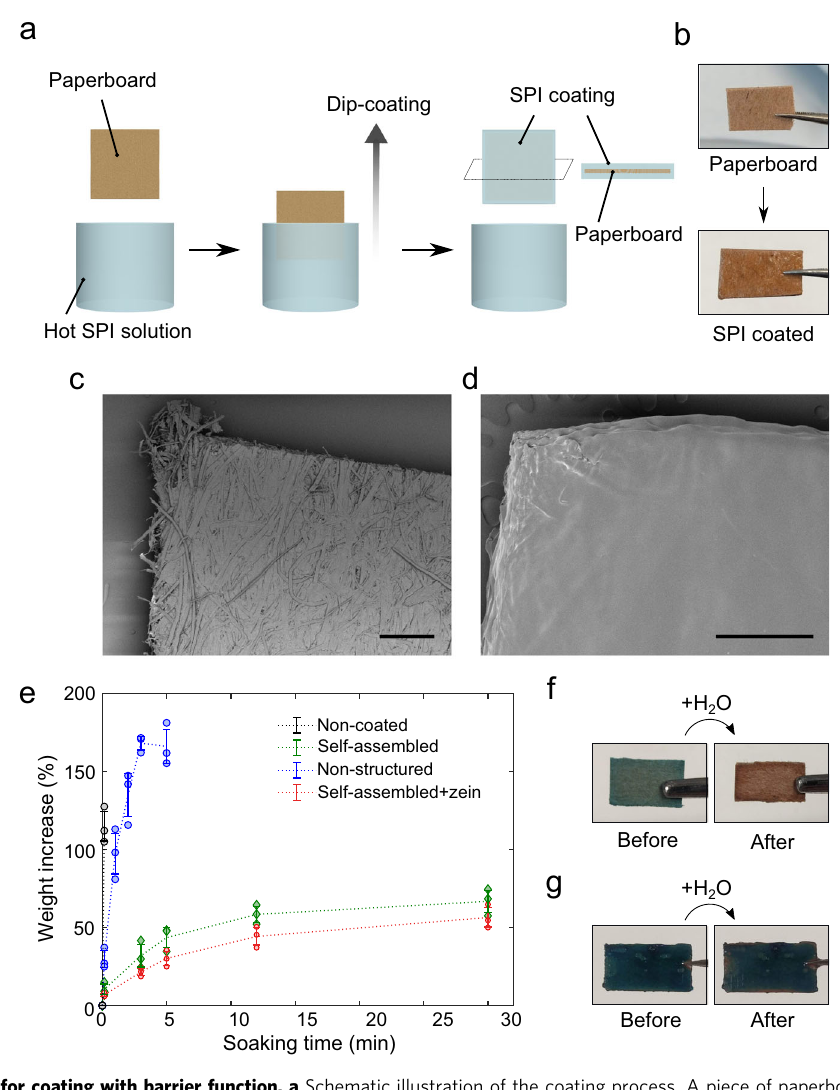
Fig. 6 Plant protein fi lm for coating with barrier function. a Schematic illustration of the coating process. A piece of paperboard was dipped in the SPI solution and pulled out slowly, leading to the formation of a gel coating its surface. The paperboard was allowed to dry at room temperature to achieve an anhydrous thin layer of coating. b Optical images of paperboards before and after SPI coating. c , d SEM images of paperboard without ( c ) and with ( d ) SPI coating. Scale bars represent 500 μ m. e Water uptake of the treated and untreated paperboards measured over 30 min studied through gravimetry. The indicated error bars represent the s.d. of the average of three independent measurements. f , g Colour changes of CoCl 2 -stained paperboards before and after immersing in water for 5 s (Supplementary Movie 1). The paperboard was prepared without ( f ) and with ( g ) SPI coating,